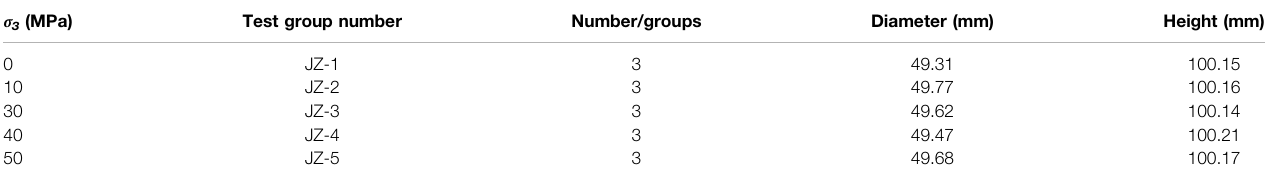
TABLE 2 | Test scheme and parameters.